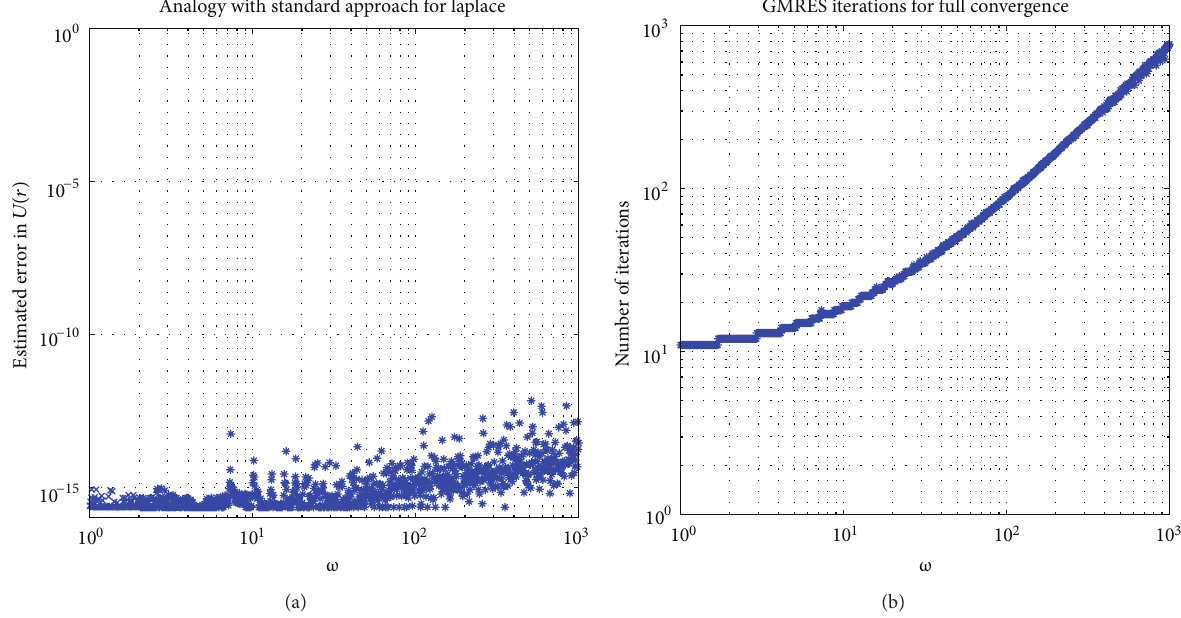
Figure 15: The exterior Neumann problem for Helmholtz equation with RCIP applied to (63). The program demo12.m is used with Γ as in (1), and 𝜃 = 𝜋/2 . The boundary condition 𝑔(𝑟) of (59) is generated by a point source at (0.3, 0.1) . (a) The absolute error in 𝑈(𝑟) at 𝑟 = (−0.1, 0.2) . (b) The number of GMRES iterations needed to meet an estimated relative residual of 𝜖 mach